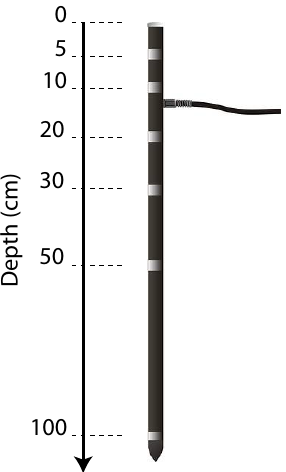
Fig. 6. Temperature probe Th3.